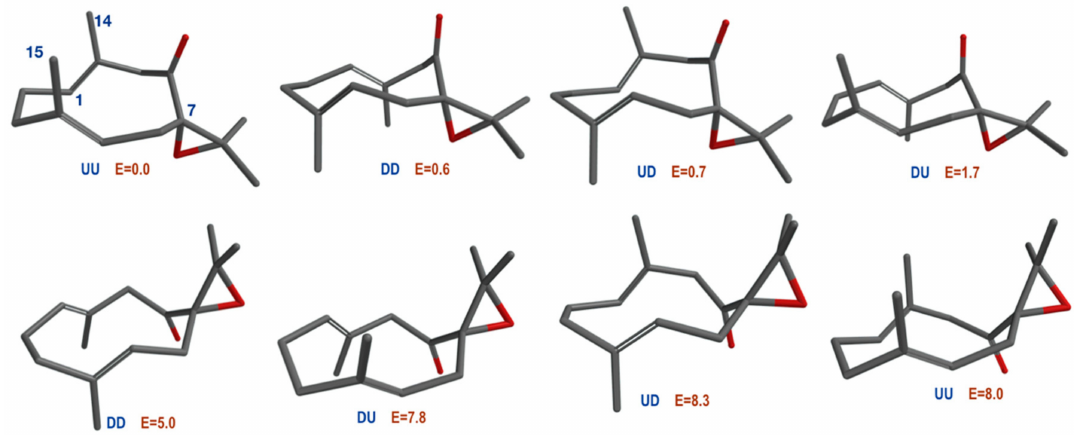
Figure 3. Main conformers of the 7 S -epimer of epoxide 13 . Relative free energies (red) to the conformer UU in kcal / mol (B3LYP-6-31 +